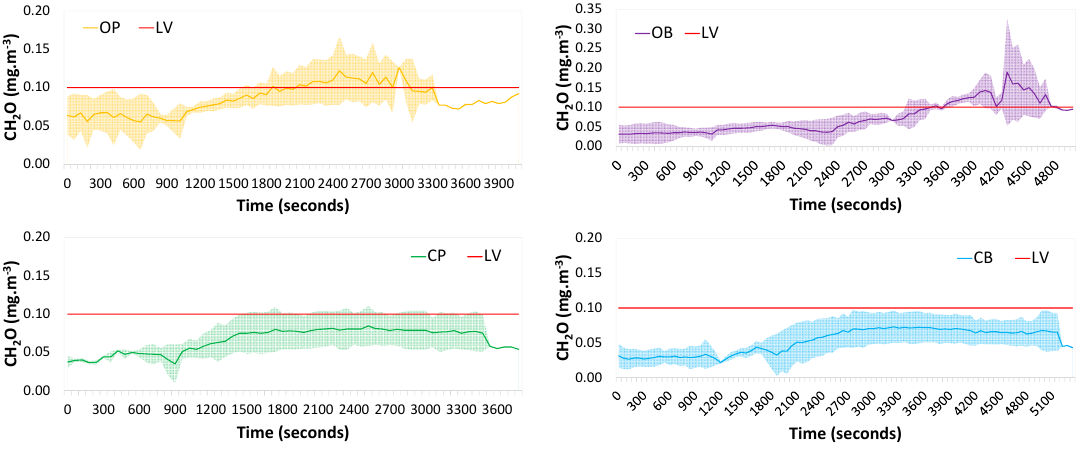
Figure 9. Temporal variability of CH 2 O (line—mean; light colored area—standard deviation) during the combustion period for the four studied conditions: ( top , left ) OP—open fireplace and pinewood, ( top , right ) OB—open fireplace and briquettes, ( bottom , left ) CP—closed (insert) fireplace and pinewood, and ( bottom , right ) CB—closed fireplace (insert) and briquettes. The red line represents the CH 2 O limit value of 0.1 mg·m − 3 defined by the Portuguese legislation [32].